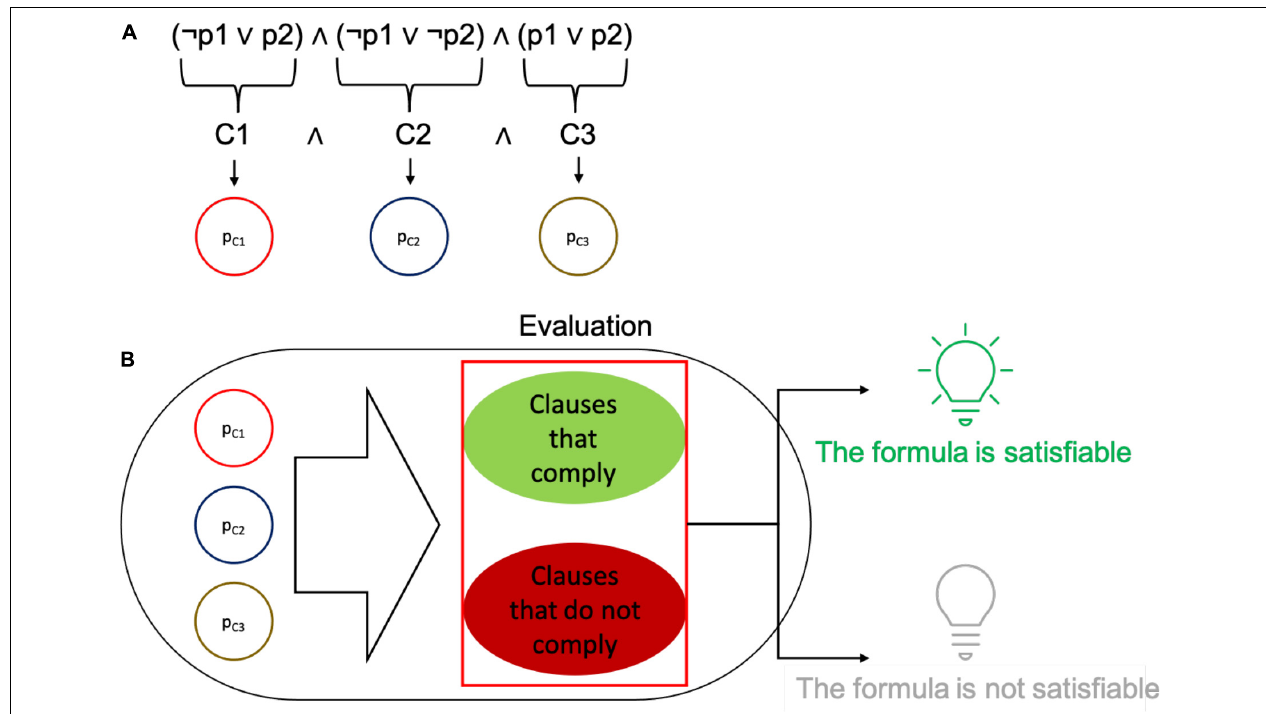
FIGURE 2 | Depiction of how the SAT problem relates to the elements in cells. (A) Clauses are identified in a propositional formula, and each of them is encoded as a single protein within a plasmid. (B) The plasmids in the cell are used to evaluate the fitness of a solution (set of plasmids seeking to satisfy the formula with their truth values). The plasmids may be present or absent. According to whether the values in the plasmid contribute to the correct satisfaction of the whole formula, if it fully complies, the cell expresses GFP, else it does not